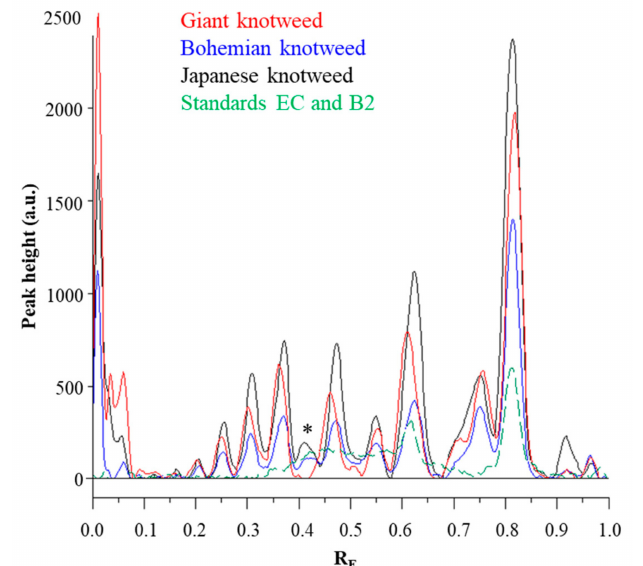
Figure 5. Comparisons of the videodensitogram of standards ( − )-epicatechin (EC; R F = 0.82) and procyanidin B2 (B2; R F = 0.63) (30 ng; dashed green line) with the videodensitograms of the fingerprint profiles of STSs (1 µ L, 50 mg/mL) from rhizomes of Japanese (black line), Bohemian (blue line) and giant knotweed (red line). The videodensitograms were obtained in absorption mode by image analysis of the HPTLC silica gel plate after the development with toluene–acetone–formic acid (3:6:1, v/v ) and after the derivatization with DMACA detection reagent. The asterisk (*) indicates the peaks that are specific to Japanese and Bohemian knotweed